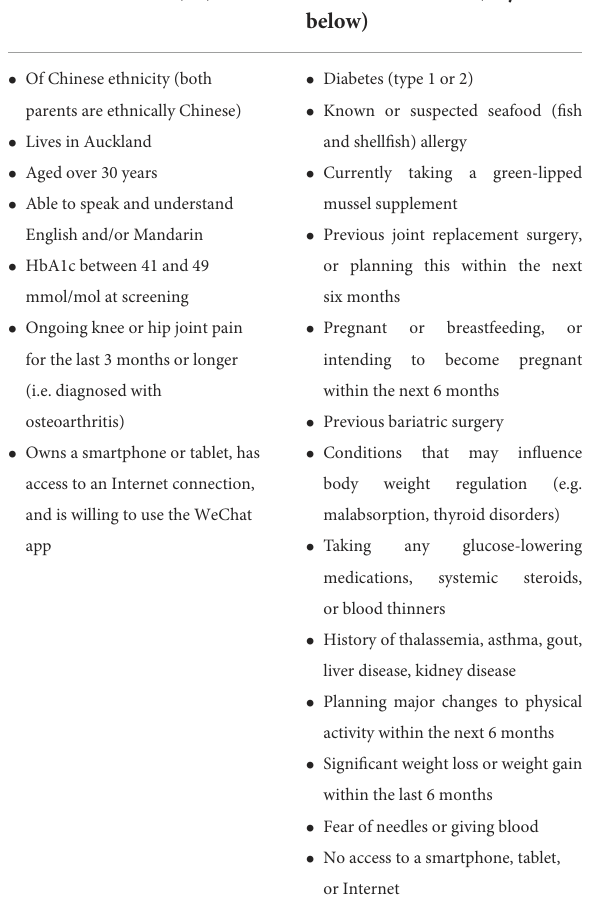
TABLE 1 Trial eligibility